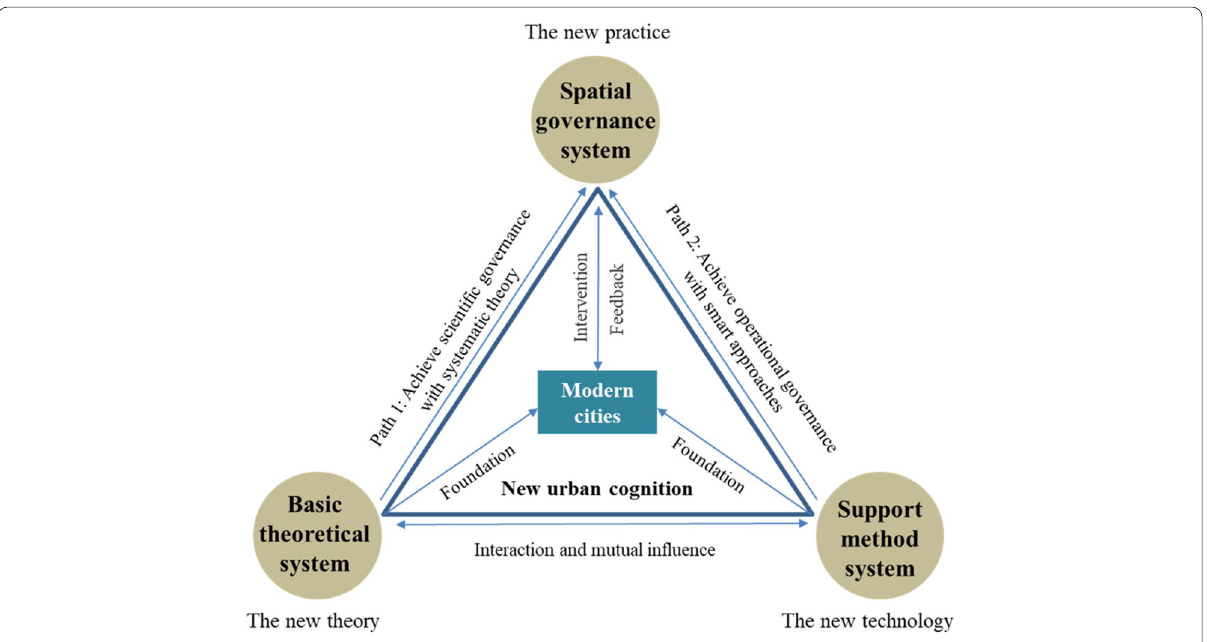
Fig. 2 The cognitive and investigative framework for modern